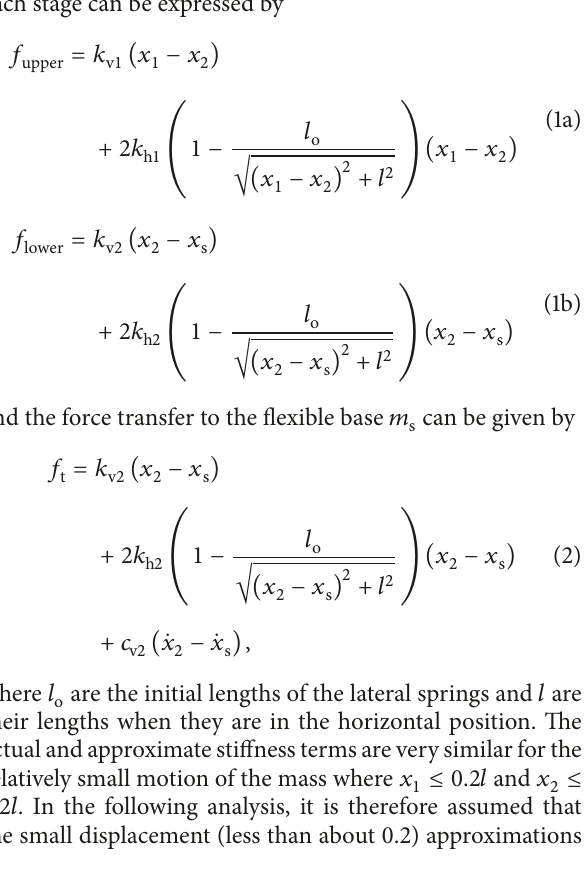
𝑚 s is the base